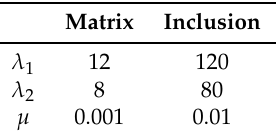
Table 1. Material